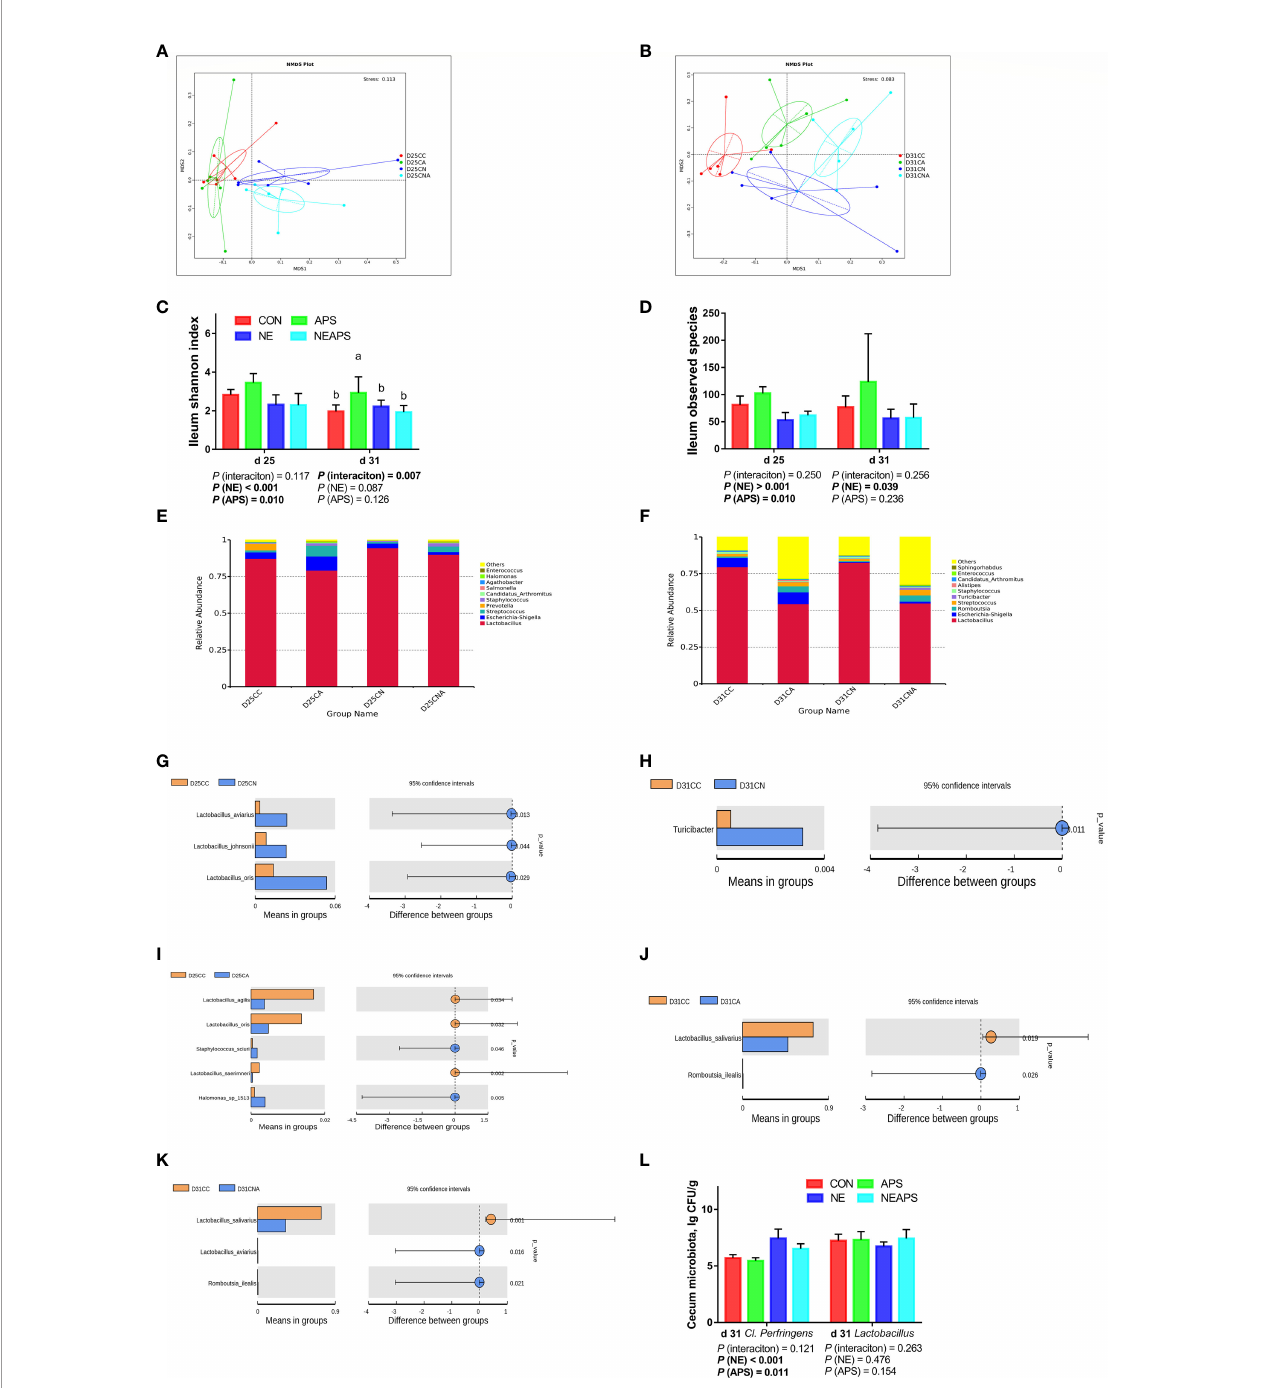
FIGURE 7 | Effects of dietary supplementation of astragalus polysaccharides on the gut microbiota of broiler chickens challenged with necrotic enteritis. The beta diversity (A, B) of ileum microbiota of broiler chickens was analyzed by non-metric multidimensional scaling (NMDS). The alpha diversity of ileum microbiota of broiler chickens was analyzed by shannon index (C) and observed species (D) . Top ten microbiota at the genus level in ileum of broiler chickens on d 25 (E) and d 31 (F) . Differential microbes in ileum of broiler chickens by T-test (G – K) . The numbers of Clostridium perfringens and Lactobacillus (L) in cecum were detected by culture count method. All graphs are presented as mean, with the standard deviation (SD) shown via the whiskers. The main effect and interaction effects were analyzed using the general linear model (GLM) procedure, with the P values for the main effects written out below each plot. The one-way ANOVA and multiple comparisons were performed when interactive effects differed signi fi cantly. The lowercase letters on the bar charts indicate signi fi cant differences ( P < 0.05). CC/CON, control group; CA/APS, APS group; CN/NE, NE infection group; CNA/NEAPS, APS infected with NE